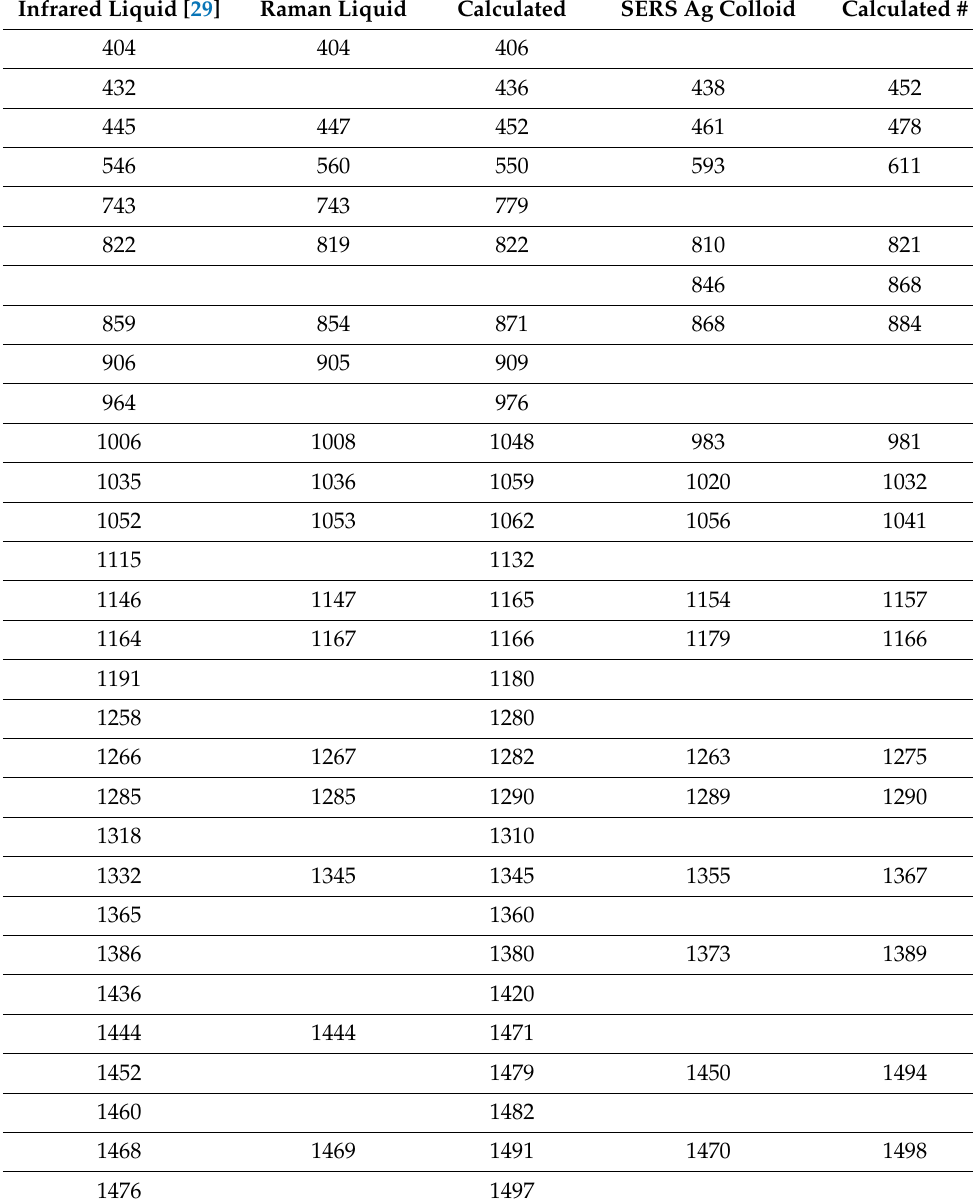
Table 1. Vibrational frequencies (cm -1 ) of both experimental and calculated